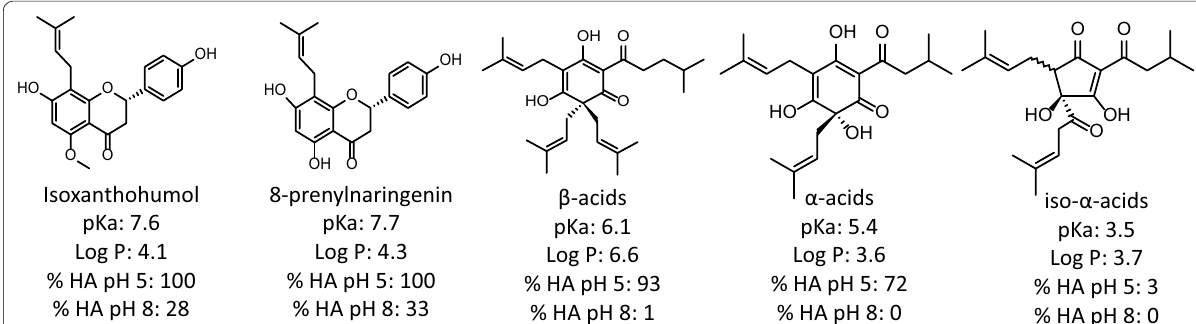
Fig. 5 Theoretic calculations of undissociated fractions (HA) of substrate IX, product 8-PN and traces of bitter acids in spent hops at pH 5 (pH of stationary phase cultures in absence of pH control) versus pH 8 (maximal tolerable pH value for Eubacterium limosum ), based on reported pKa values and the Henderson–Hasselbalch equation (Simpson and Smith 1992). Considering the relatively high (estimated) log P values of the most abundant antibacterial hop compounds, bioavailability via diffusion into the bacterial cells may be much altered based on the pH of the medium. %HA: undissociated fraction of the weak acids. The structures in the figure are the most commonly represented stereo form of the